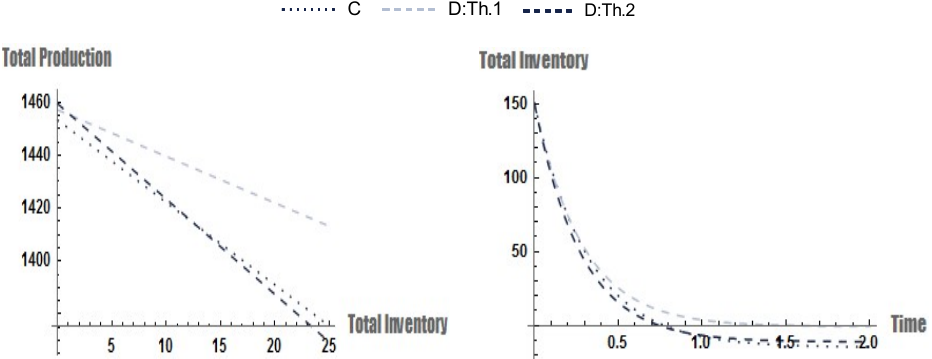
Figure 2. Total production quantities and total inventory.